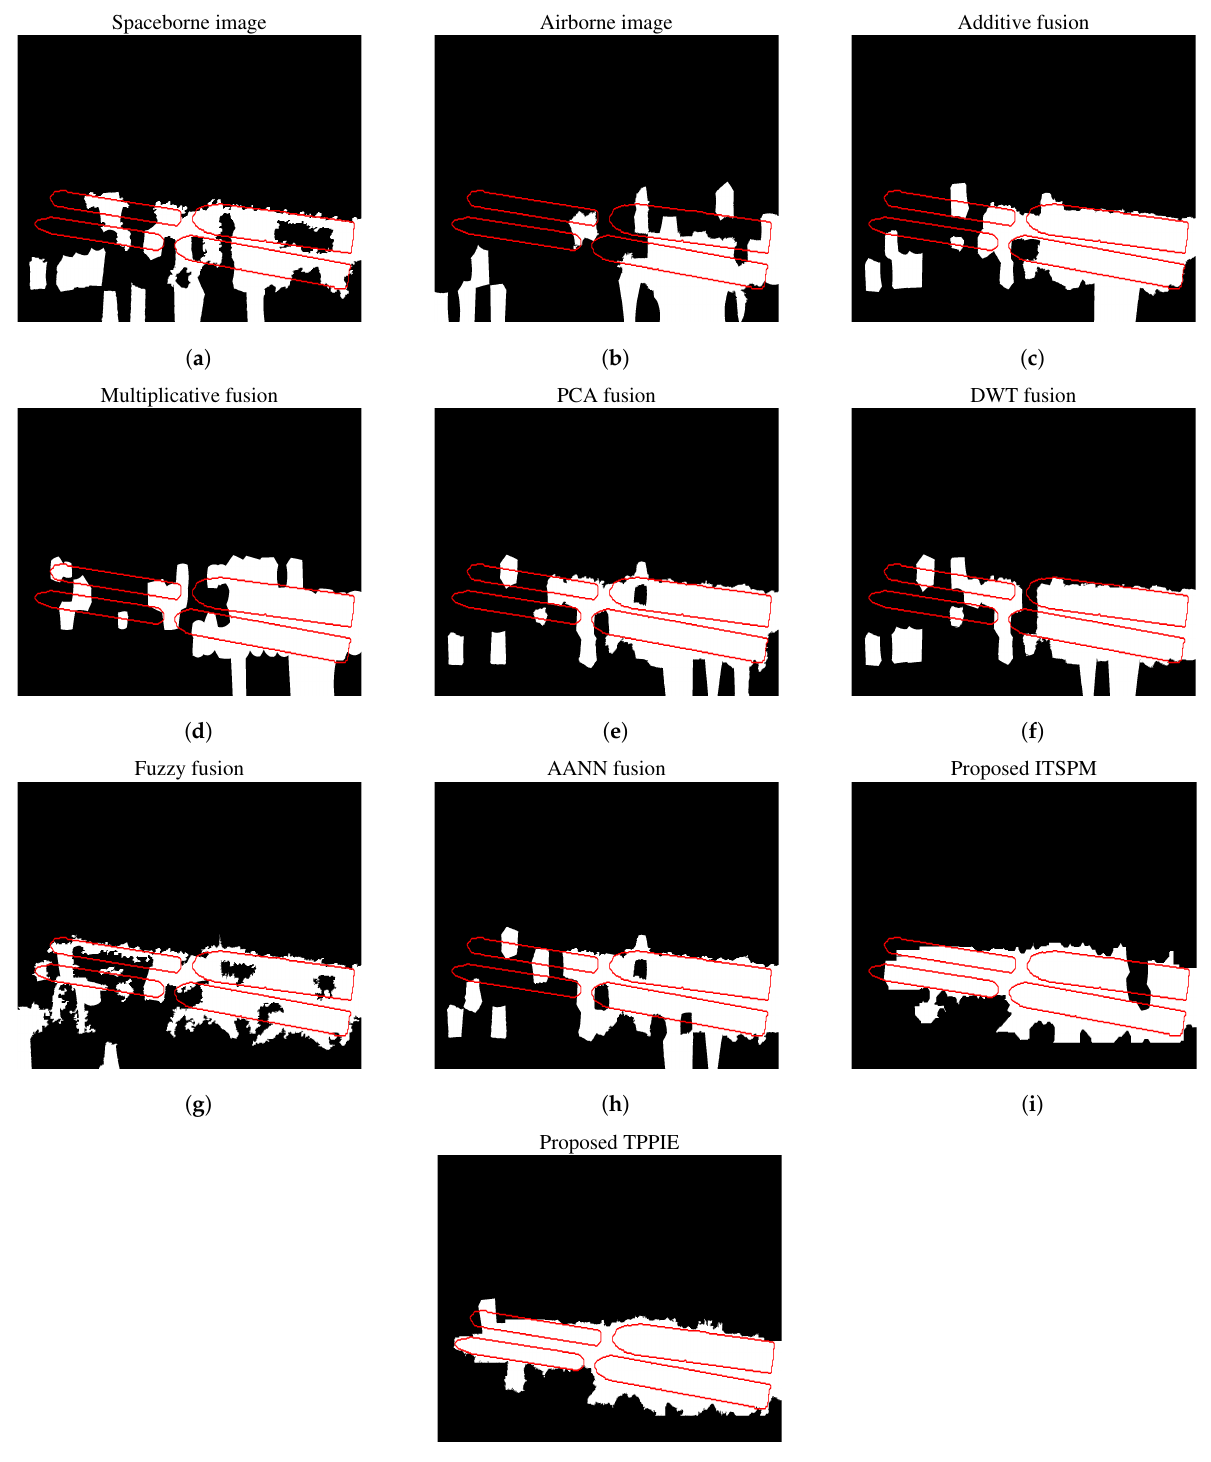
Figure 11. Superpixel-based detection results of different methods for Experimental Scene 3 with respect to PFA = 0.1: ( a ) Spaceborne image processing (PD = 0.6133); ( b ) airborne image processing (PD = 0.3960); ( c ) additive fusion [10] (PD = 0.7253); ( d ) multiplicative fusion [10] (PD = 0.6850); ( e ) PCA fusion [12] (PD = 0.7420); ( f ) DWT fusion [13] (PD = 0.7243); ( g ) fuzzy fusion [16] (PD = 0.7528); ( h ) AANN fusion [18] (PD = 0.7305); ( i ) proposed ITSPM fusion (PD = 0.8998); and ( j ) proposed TPPIE fusion (PD = 0.9796 ). The red lines denote the boundaries of target vessels. The proposed TPPIE fusion method had the best detection